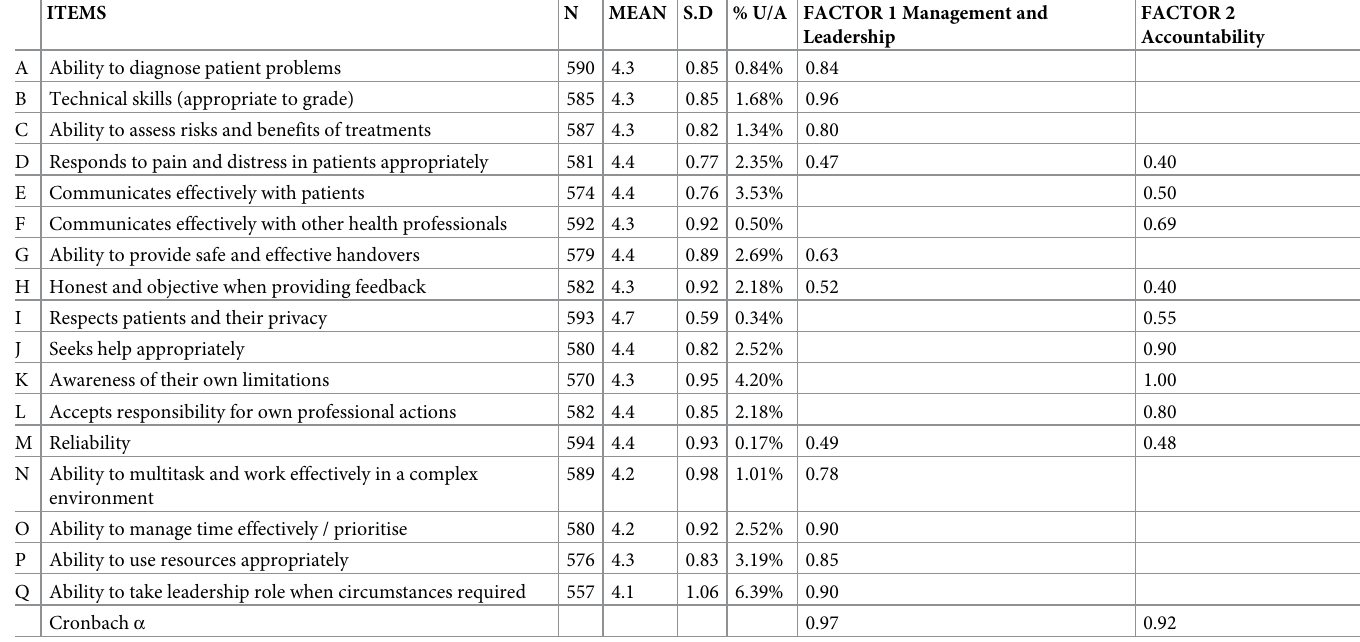
Table 1. Details about questions, response rate and unable to assess rate, factor analysis and Cronbach α scores for medical colleagues.